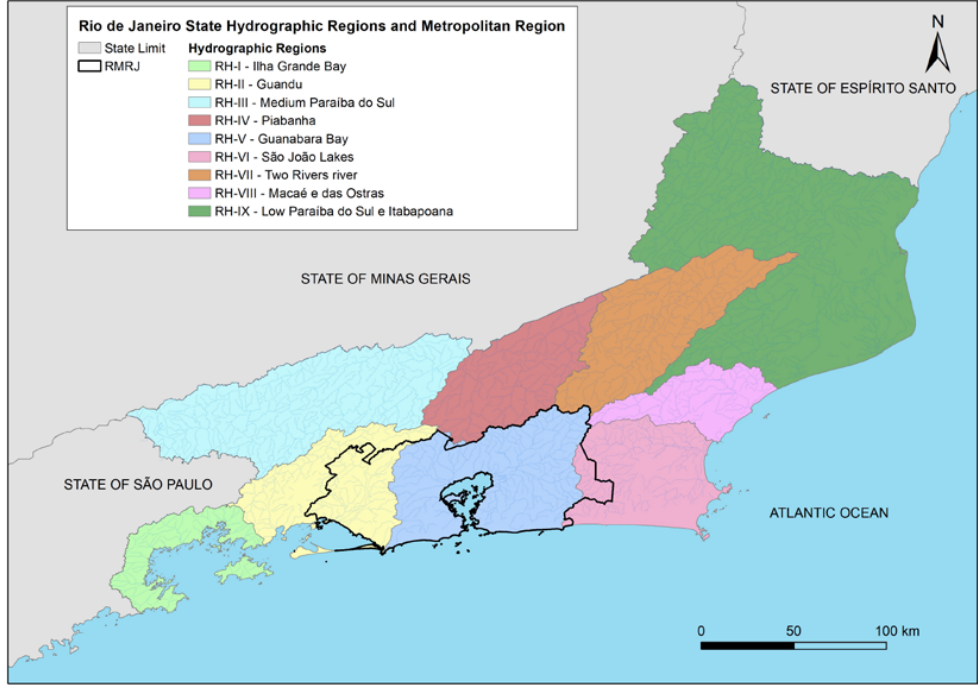
Figure 2. Rio de Janeiro State and Rio de Janeiro Metropolitan Region (RJMR).